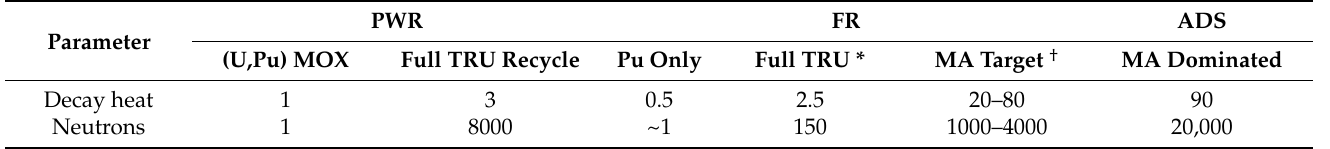
Table 9. Relative impacts of recycling strategies for handling materials in fuel fabrication